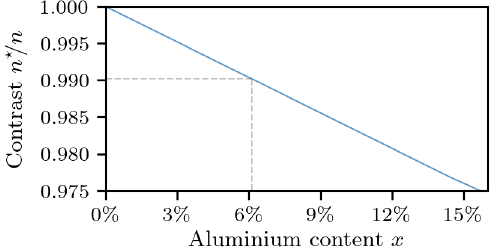
Figure 9. The refractive index contrast of Al x Ga 1 − x N, with respect to GaN as a function of the aluminium content x (data extrapolated from [2]). A contrast of 0.990 corresponds to an aluminium content of